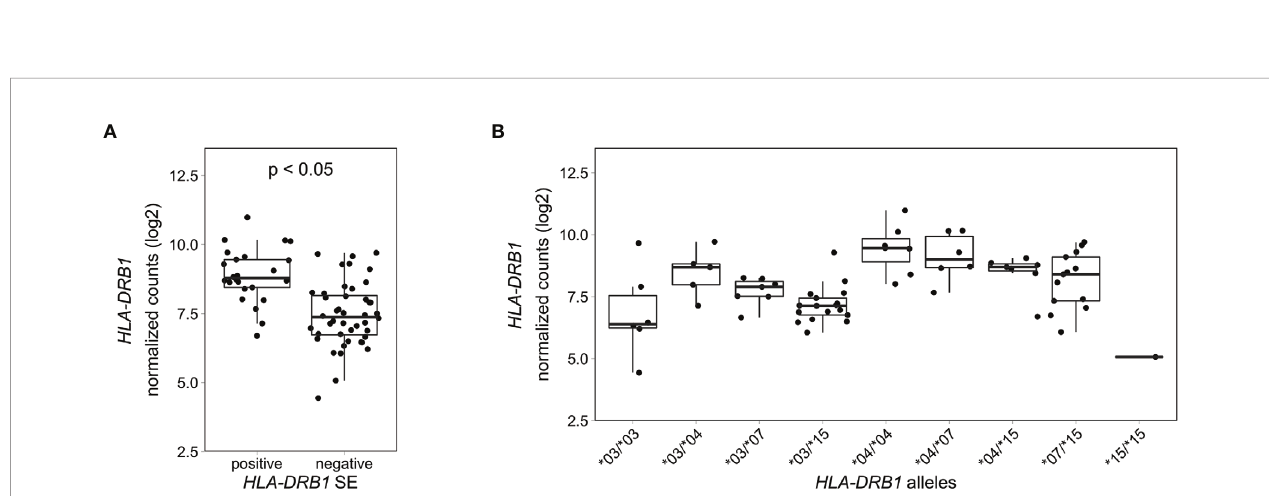
FIGURE 5 | HLA-DRB1 expression levels in whole blood samples of healthy individuals of the GTEx project. (A) HLA-DRB1 gene expression in whole blood samples of HLA-DRB1 SE-positive [*04 ( n = 25)] and SE-negative [*03, *07, and *15 ( n = 44)] individuals. (B) HLA-DRB1 gene expression in whole blood samples of individuals carrying different combinations of HLA-DRB1 alleles [*03/*03 ( n = 6), *03/*04 ( n = 5), *03/*07 ( n = 7), *03/*15 ( n = 17), *04/*04 ( n = 7), *04/*07 ( n = 6), *04/*15 ( n = 7), *07/*15 ( n = 13), and *15/*15 ( n = 1)]. P, adjusted P -value